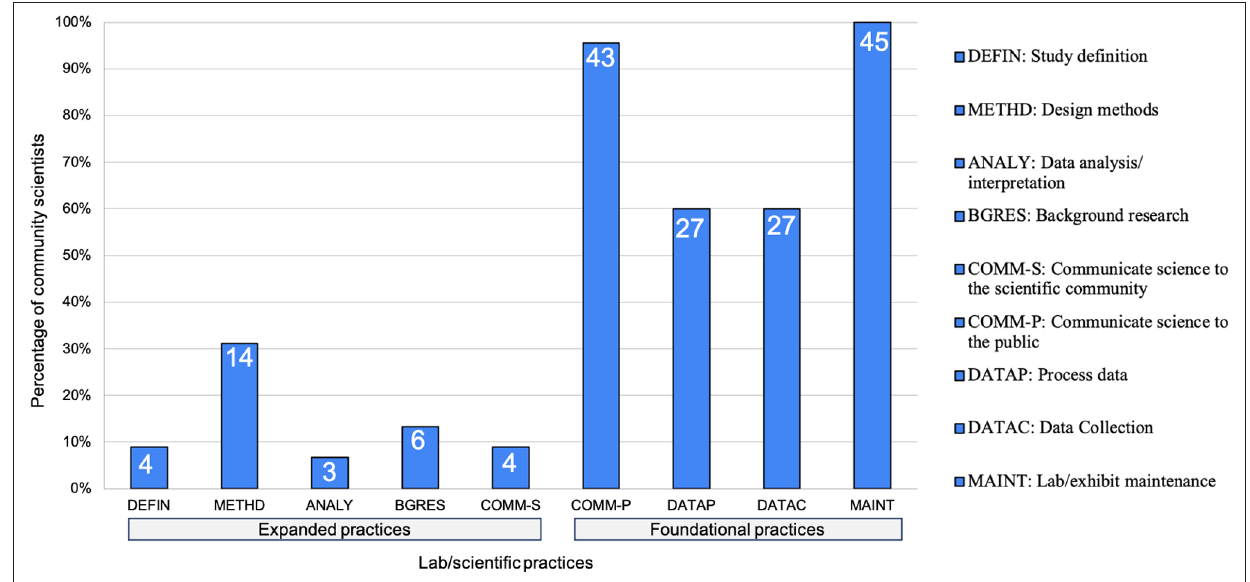
Figure 1 Prevalence of scientific practices among 45 participants. The figure depicts the percent and number of participants who participated in each scientific practice (definitions also in Table